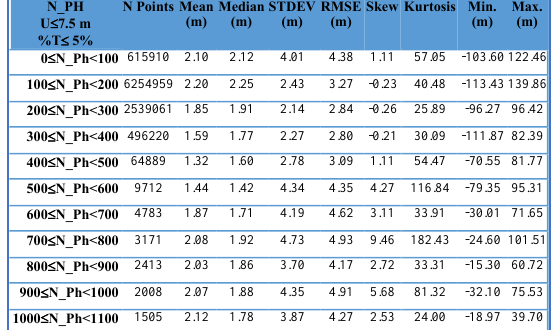
Table 7. Statistics for elevation differences SRTM90 – h_te_interp (in m) for h_te_uncertainty less or equal to 7.5 m Ground Photons per Segment ( n_te_photons ) corresponding to Figure 6 above, using 100 photons bin increments.